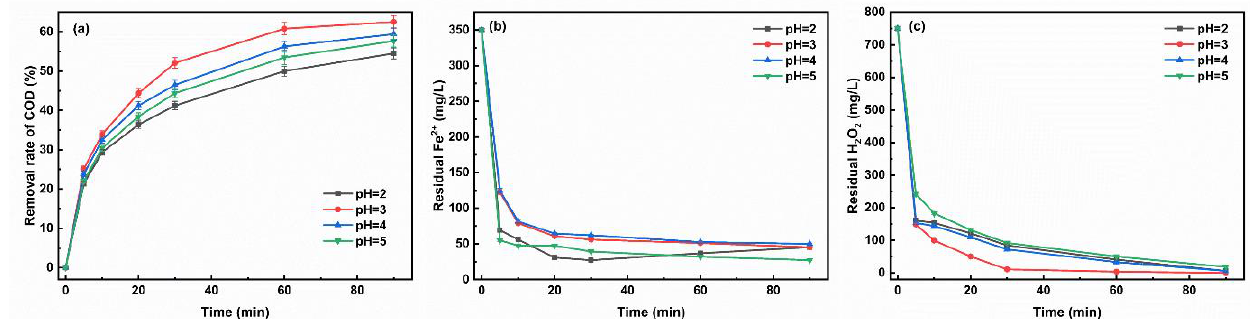
Figure 4. Influence of initial pH on COD removal rate ( a ), the residual concentration of Fe 2+ ( b ), and the residual concen- tration of H 2 O 2 ( c ).